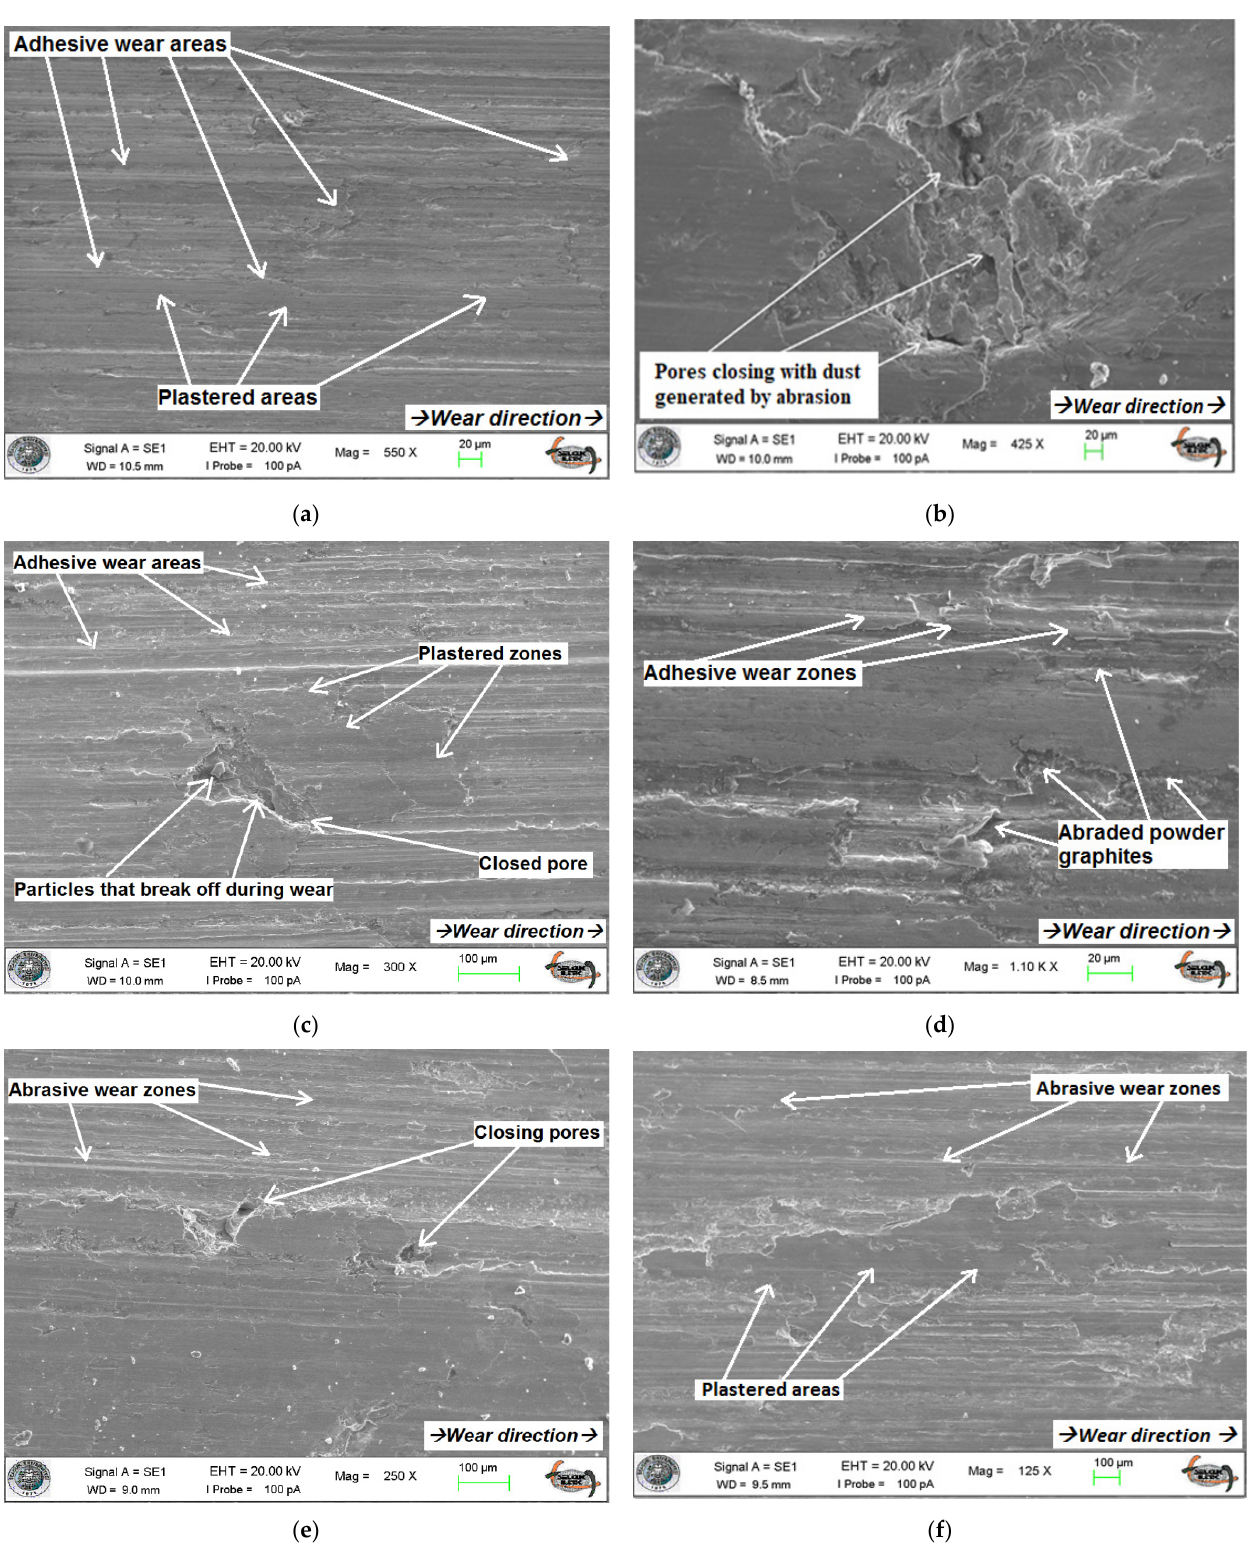
Figure 3. SEM images of different composites after wear ( a ) 100C, ( b ) 60C40G, ( c – e ) 70C30G, and ( f ) 90C10G samples produced at 450 °C and 820 MPa.